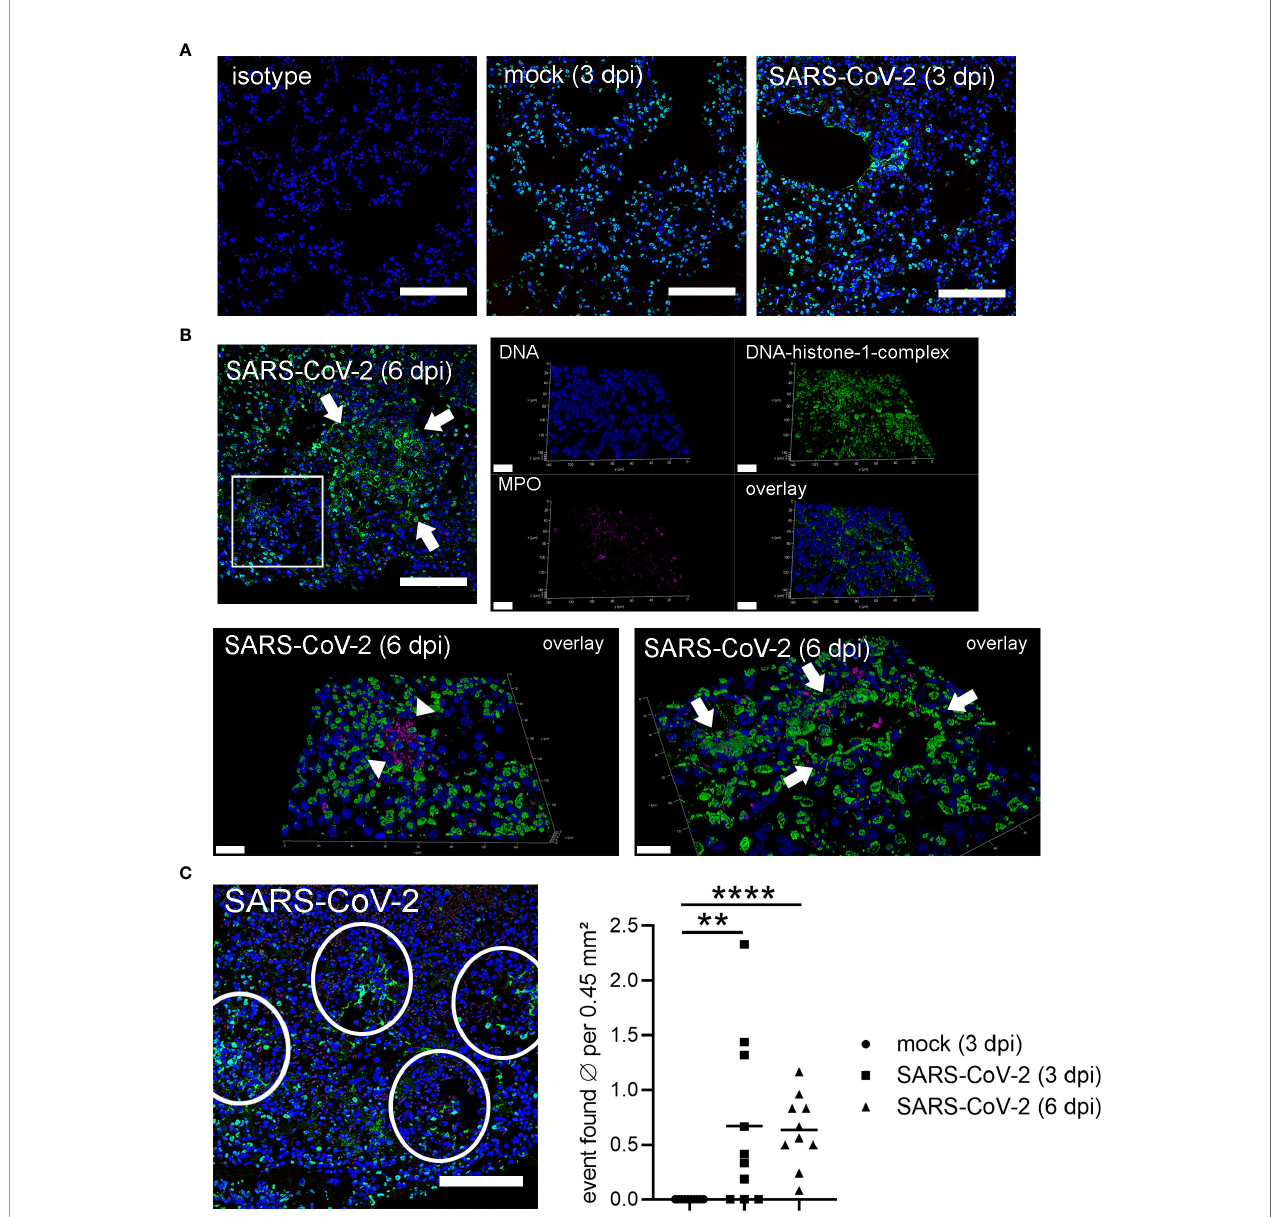
FIGURE 3 | Detection of NETs in lungs only in SARS-CoV-2 infected hamsters. (A) Lung sections (3 dpi) form the non-infected group (mock) and infected group (SARS-CoV-2) were analyzed by confocal immuno fl uorescence microscopy for NET structures. The settings were adjusted to a respective isotype control. Representative images are presented (blue = DNA, green = DNA-histone-1-complex). (B) Lung sections (6 dpi) from the infected group (SARS-CoV-2) were analyzed for NET structures and NETs were detected. Representative 3D images of z-stacks were constructed with LAS X 3D Version 3.1.0 software (Leica) (upper panel: 9.57 µm consisting of 58 sections, lower panel left side: 12.25 µm consisting of 74 sections, lower panel right side: 8.22 µm consisting of 50 sections). Arrows show NET structures; arrow heads show myeloperoxidase (MPO). Representative images are presented (blue = DNA, green = DNA-histone-1-complex, magenta = MPO). Scale bars in all 3D images = 20 µm, scale bar 2D image = 100µm. (C) Semiquantitative analysis of NET formation in SARS-CoV-2-infected animals (3 dpi and 6 dpi) was signi fi cantly increased compared to mock animals. One representative image for counting events is shown. The mean of NET-positive areas was calculated for the analyzed area. The statistical analysis was calculated with an unpaired one-tailed Mann-Whitney test (**p = 0.0015; ****p < 0.0001). Scale bar = 100 µm. Settings of the immuno fl uorescence microscope were adjusted to a respective isotype